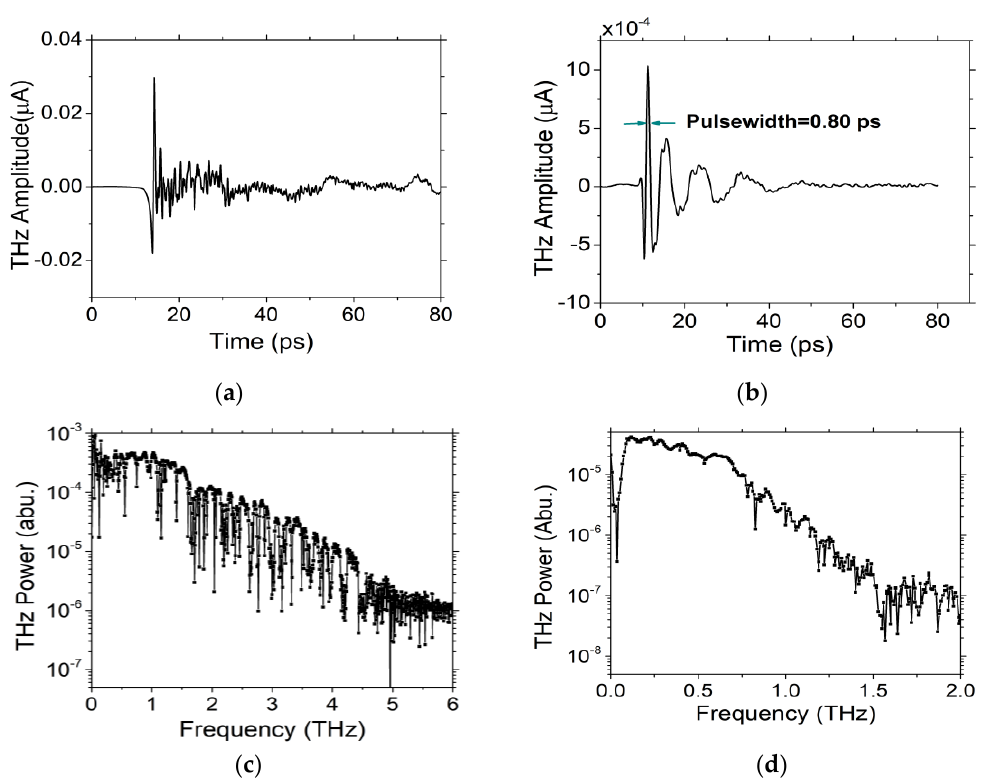
Figure 4. ( a ) The waveform in time domain when the pulsed device was pumped with 780 nm pulsed laser. ( b ) The waveform in time domain when the pulsed device was pumped with 1550 nm pulsed laser. ( c ) The power spectrum of the 780 nm driven radiation. ( d ) The power spectrum of the 1550 nm driven radiation.